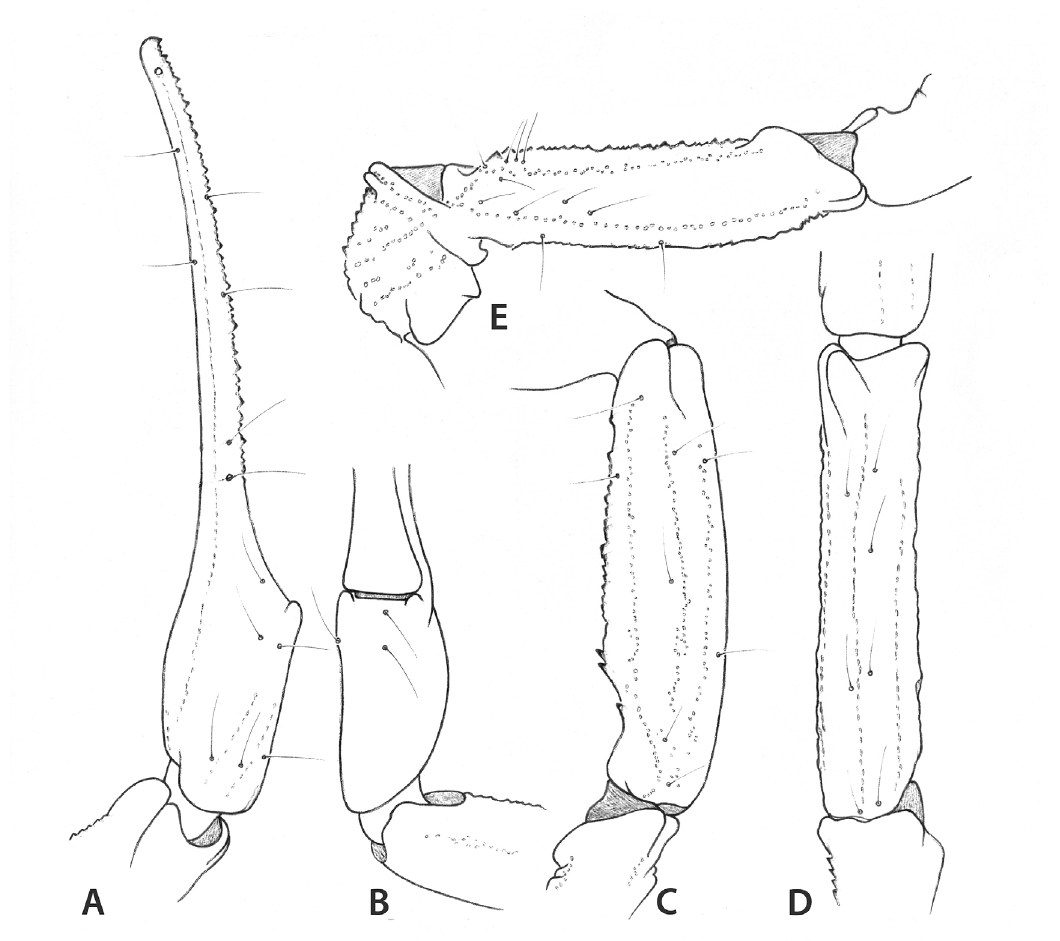
Figure 5. Leiurus dekeyseri sp. n. Female holotype. Trichobothrial pattern. (A, B) Chela, dorso-external and ventral aspects. (C, D) Patella, dorsal and external aspects. (E) Femur, dorsal